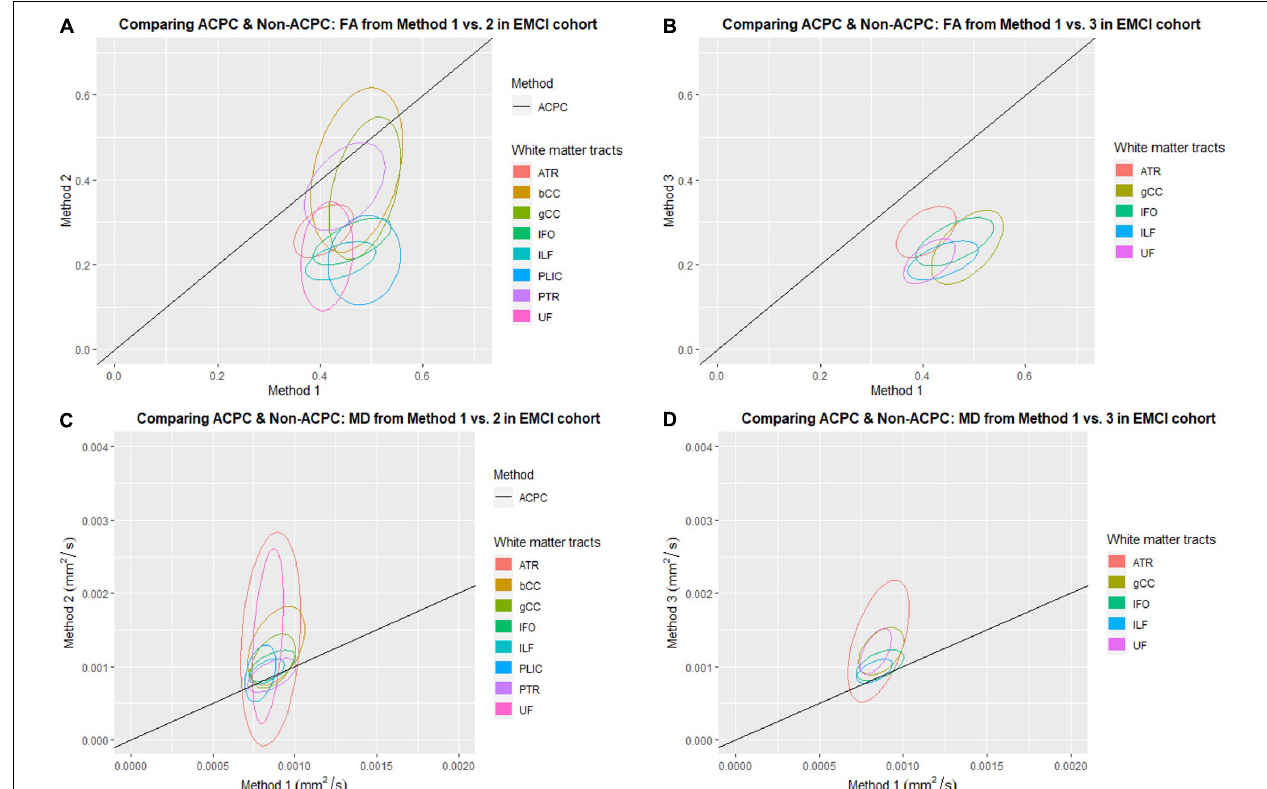
FIGURE 3 | Distribution of scatter plots of FA and MD obtained using Methods 2 and 3 against Method 1 (ACPC aligned and co-registered) across white matter tracts in the early mild cognitive impairment (EMCI) cohort. The ellipses assume a multivariate normal distribution with the mean at the center and area of the ellipse representing 95% confidence level. gCC, genu of the corpus callosum; bCC, body of the corpus callosum; ATR, anterior thalamic radiation; IFO, inferior fronto-occipital fasciculus; ILF, inferior longitudinal fasciculus; PLIC, posterior limb of the internal capsule; PTR, posterior thalamic radiation; UF, uncinate fasciculus. (A) Comparing ACPC and Non-ACPC: FA from Method 1 vs. 2 in EMCI cohort. (B) Comparing ACPC and Non-ACPC: FA from Method 1 vs. 3 in EMCI cohort. (C) Comparing ACPC and Non-ACPC: MD from Method 1 vs. 2 in EMCI cohort. (D) Comparing ACPC and Non-ACPC: MD from Method 1 vs. 3 in EMCI cohort. i.e., in AD (neurodegenerative), EMCI (mild